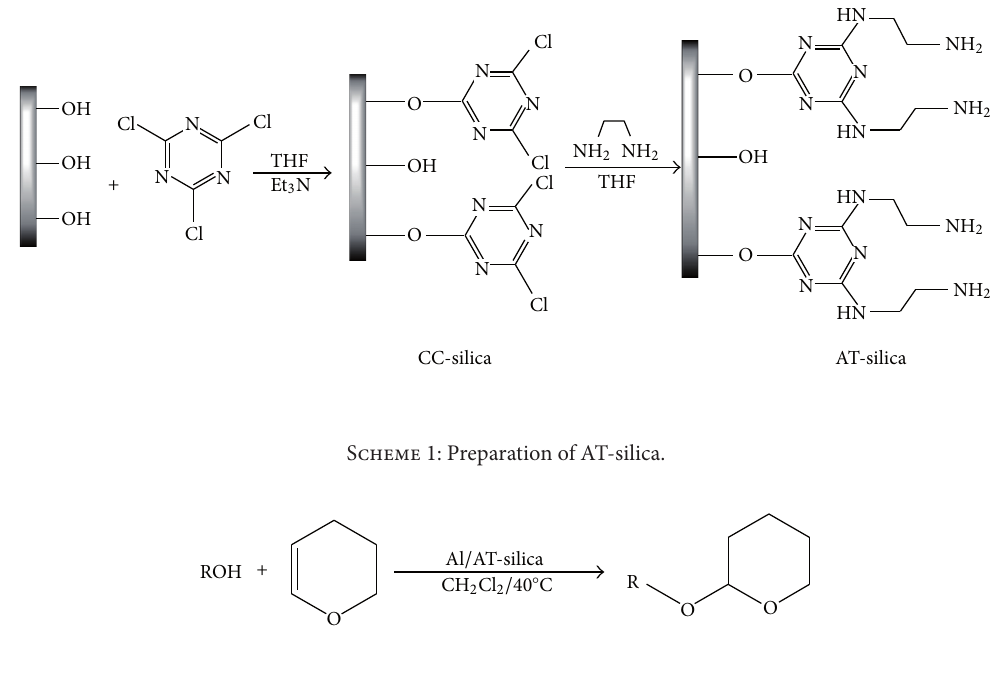
S 2: Tetrahydropyranylation of alcohols and